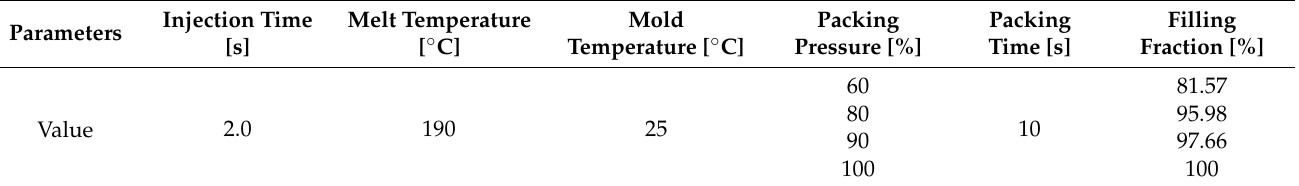
Table 6. Processing parameters of the packing pressure study. Only packing pressure was